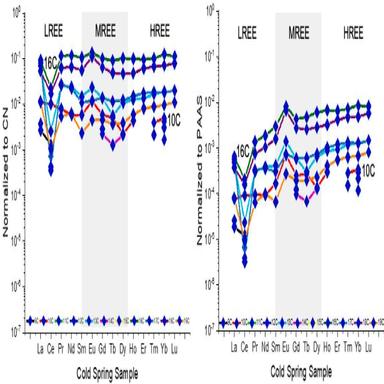
Spider-web diagrams of REE concentrations of the cold spring water samples normalized by CN and PAAS, both showing pronounced negative Ce and positive Eu anomalies. HREE enrichment and the Ce and Eu anomalies are revealed more clearly by PAAS normalization (right).